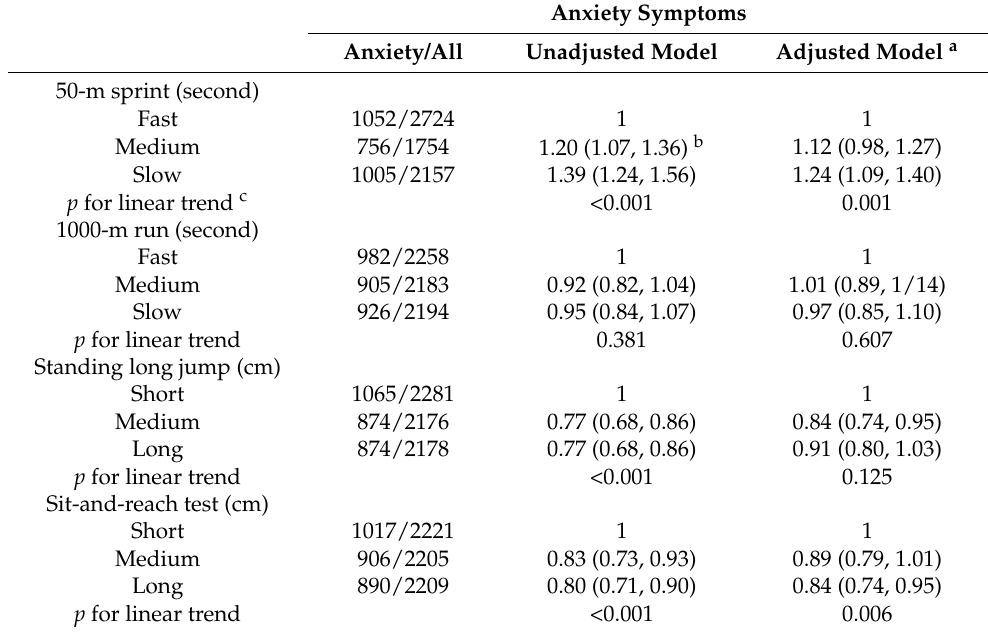
Table 3. Adjusted relationship between physical fitness and anxiety symptoms in 6635